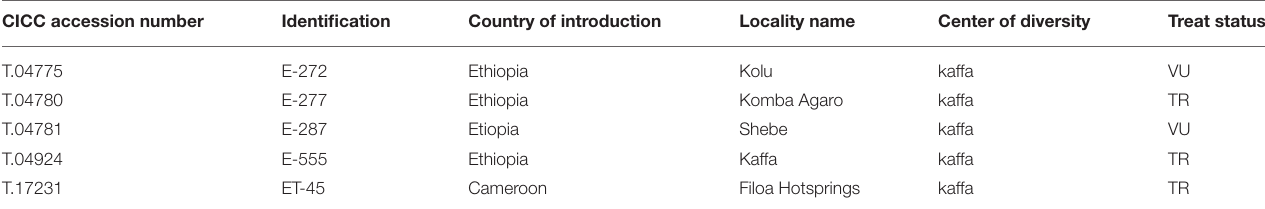
TABLE 7 | Most unique accessions in the FAO and ORSTOM collections ( C. arabica